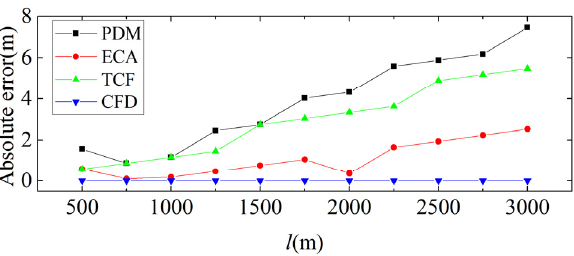
Figure 8. The absolute error values for various location methods of the cables with different lengths.